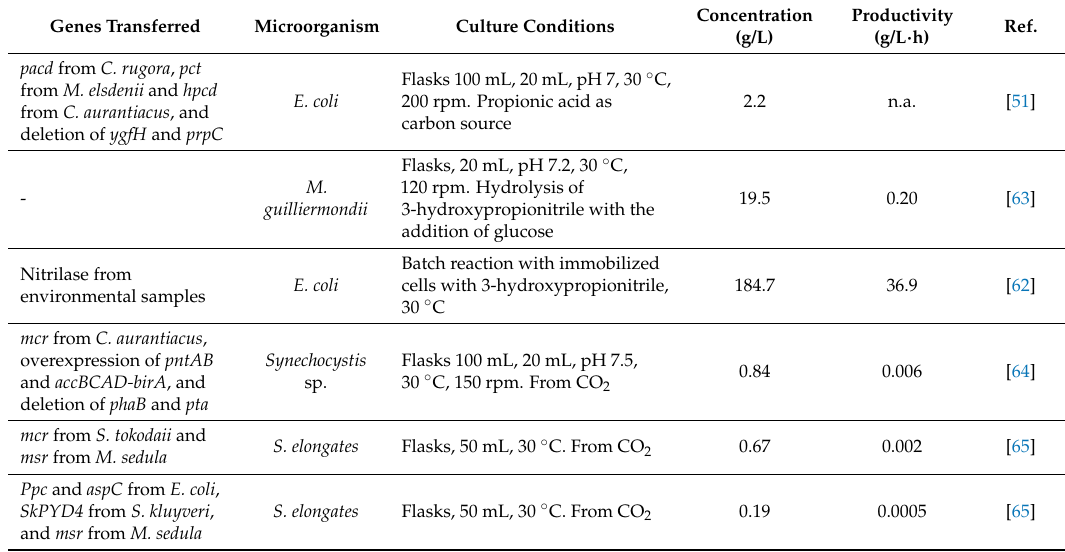
Table 7. Results of 3HP production from carbon sources other than glycerol and glucose (sugars). Genes